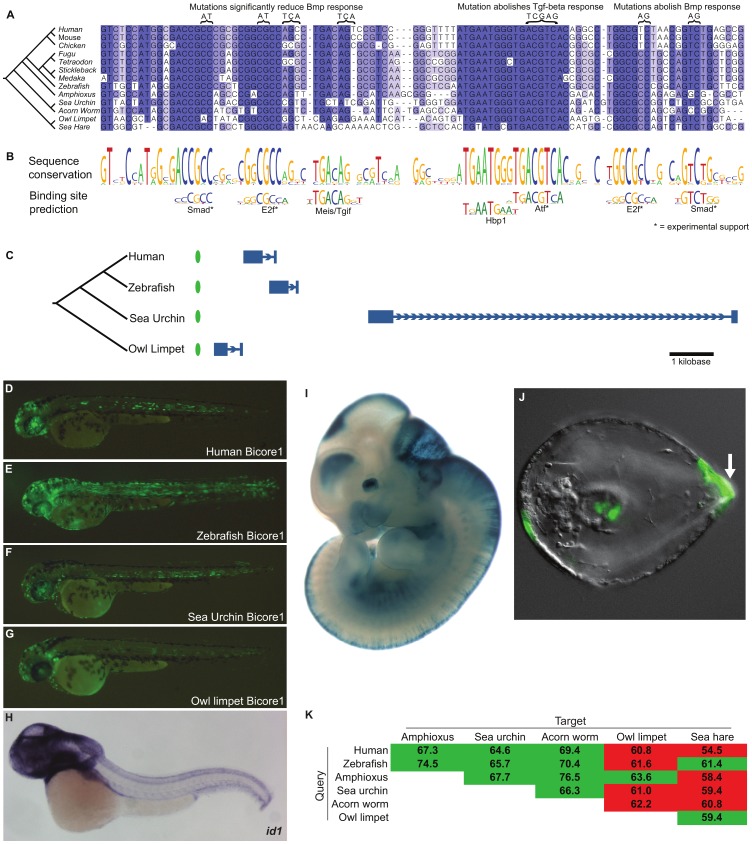
Bicore1 is a bilaterian conserved enhancer.(A) Multiple alignment of Bicore1. Above the alignment are mutations that reduce the cis-regulatory function of Bicore1 in response to Tgf-beta/Bmp signaling in a luciferase assay [20], [21], [24]. (B) Conservation profile of Bicore1 showing that conserved blocks in the alignment correspond to transcription factor binding preferences. (C) Each instance of Bicore1 (green oval) is syntenic to a conserved Id gene (blue gene structure). (D–G) Zebrafish transgenic assay showing (D) human, (E) zebrafish, (F) sea urchin, (G) owl limpet instances of Bicore1 drive expression in the central nervous system at 48 hours. (H) Whole-mount in situ hybridization of id1 in zebrafish shows expression throughout the central nervous system, courtesy of zfin.org. (I) A human genomic region containing Bicore1 drives expression in the forebrain, midbrain, hindbrain, neural tube, and eye of embryonic day 11.5 mice, courtesy of enhancer.lbl.gov. (J) A sea urchin genomic region drives expression in the aboral ectoderm (arrow) in the early pluteus stage sea urchin larva. (K) Pairwise percent identities of Bicore1 sequences. Green cells indicate a query sequence (row) that detected Bicore1 in the target (column). Red cells indicate query sequences that did not detect Bicore1 in the target.